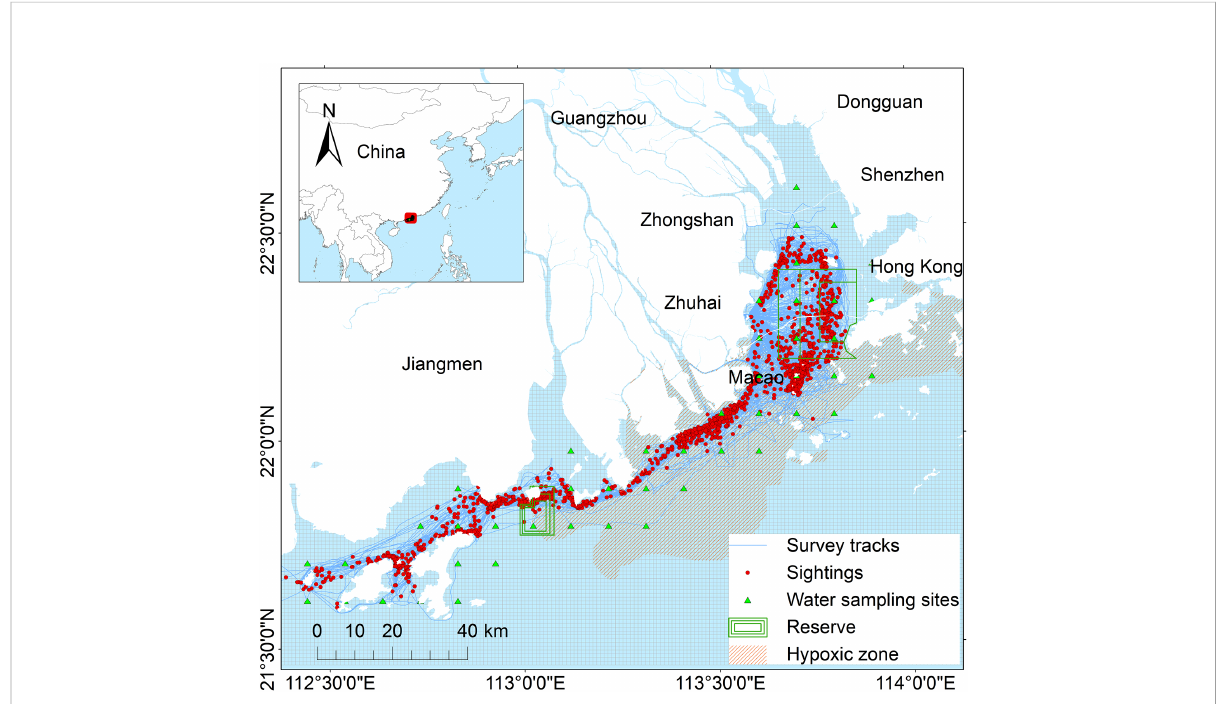
FIGURE 1 The study area embedded with a fi shnet (Each cell size represents 1 ×1 km) in the Pearl River Estuary during 2015-2021. Legends include locations of Indo-Paci fi c humpback dolphin sightings (red dots), survey tracks (blue lines), water sampling sites (green triangles), reserve area (green boxes) and hypoxic zone (orange shaded